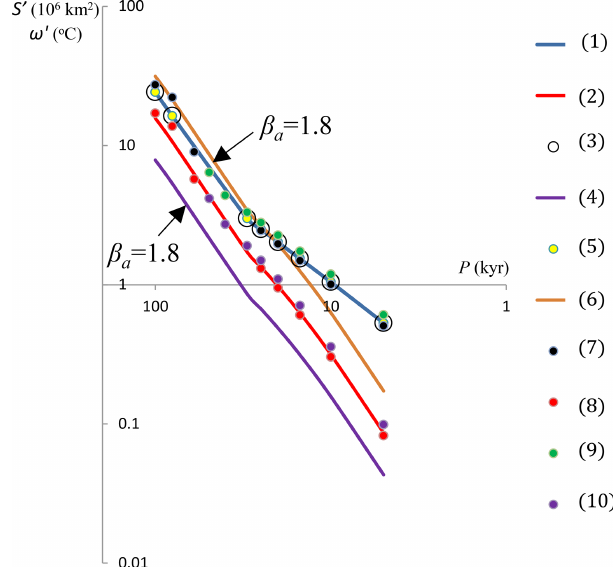
Figure 2. The system response to a single-sinusoid external forc- ing of constant amplitude and different periods: (1) ´ S with refer- ence parameter values; (2) ´ ω with reference parameter values; (3) ´ S with intensive climate temperature and weak albedo positive feed- backs; (4) ´ ω with intensive climate temperature and weak albedo positive feedbacks; (5) ´ S with weak climate temperature and inten- sive albedo positive feedbacks; (6) ´ ω with weak climate tempera- ture and intensive albedo positive feedbacks; (7) ´ S with intensive climate temperature positive and ice-sheet basal temperature neg- ative feedbacks; (8) ´ ω with intensive climate temperature positive and ice-sheet basal temperature negative feedbacks; (9) ´ S with weak climate temperature positive and ice-sheet basal temperature nega- tive feedbacks; and (10) ´ ω with weak climate temperature positive and ice-sheet basal temperature negative